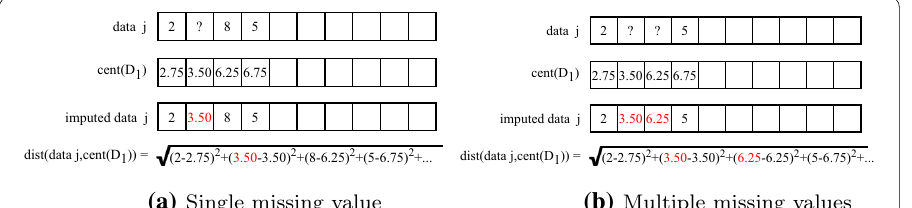
Fig. 6 MVI process